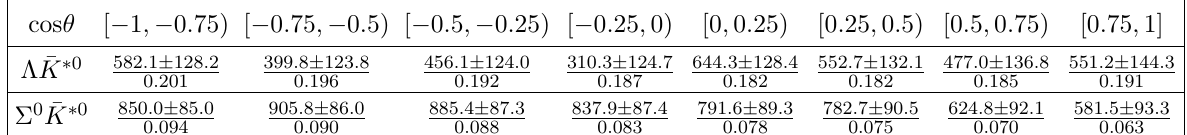
Table 4 . The values of Signal yield in Ξ 0 → Λ ¯ K ∗ 0 and Ξ 0 c